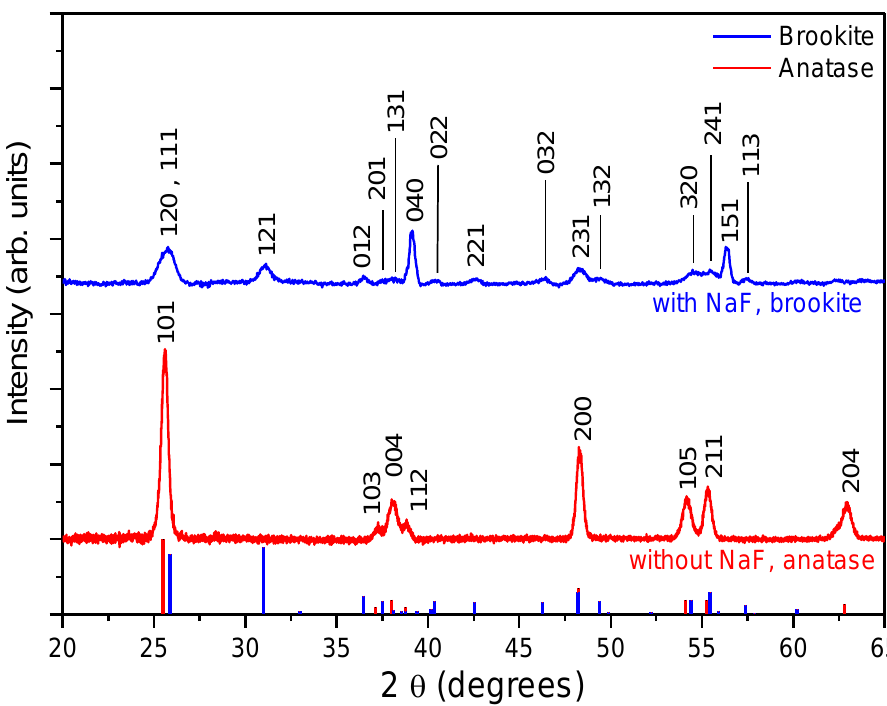
Figure 1. XRD patterns for the brookite (blue) and anatase (red) samples. The positions of the standard reflections for brookite (JCPDS No. 29-1360) and anatase (JCPDS No. 21-1272) are respectively shown as blue and red vertical bars at the bottom.